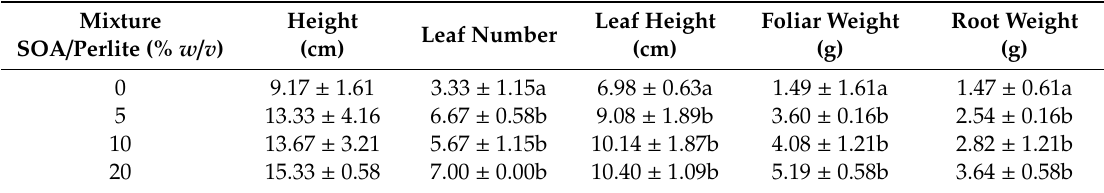
Table 3. Growth parameters of tomato plants grown in di ff erent mixtures of SOA:perlite. The values represent the mean ± standard deviation, calculated based on 15 repetitions. Di ff erent letters represent statistical di ff erences according to the Tukey test ( p <